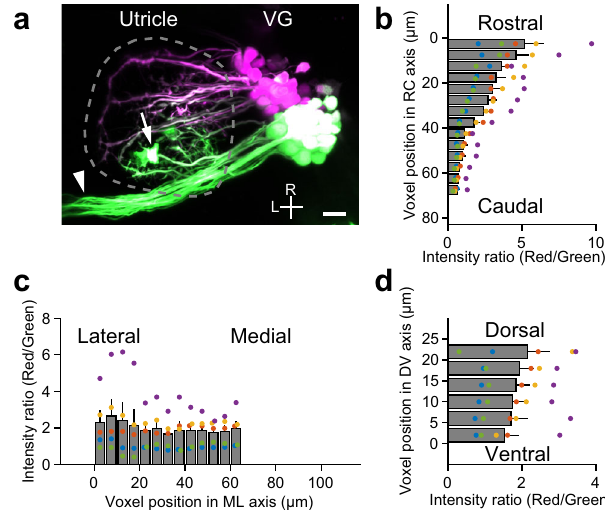
Fig. 7 | VGNs innervate utricular HCs in a topographic manner. a Maximum intensity projection image of VGNs expressing Kaede in a Tg(hspGFF53A; UAS:- Kaede) larva at 5 dpf. Green-Kaede (green) is photoconverted to red-Kaede (magenta)onlyintherostralvestibularganglion(VG)somata.Dashedlineencloses the utricle. Horizontalcanalnerve (arrowhead) and ectopic Kaede-expressingcells (asterisk)overlappingtheutricleareexcludedfromquantitativeanalysis.R:rostral. L: lateral. Scale bar: 10 μ m. Distribution of voxel fl uorescence intensity ratio (red/ green) in utricles in the rostrocaudal (RC) ( b ), mediolateral (ML) ( c ), and dorso- ventral (DV) ( d ) axes. Mean and SEM from 5 utricles. Large ratio values indicate a largeamountofphotoconvertedred-Kaede fl uorescenceinthevoxels.Sourcedata are provided as a Source Data fi